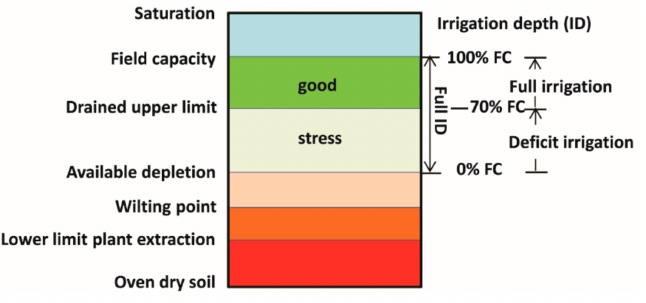
Figure 5. Schematic illustration of the soil water reservoir concepts of varied irrigation depth under field capacity irrigation scenarios (adjusted from [89]). FC is field capacity, full ID is full irrigation